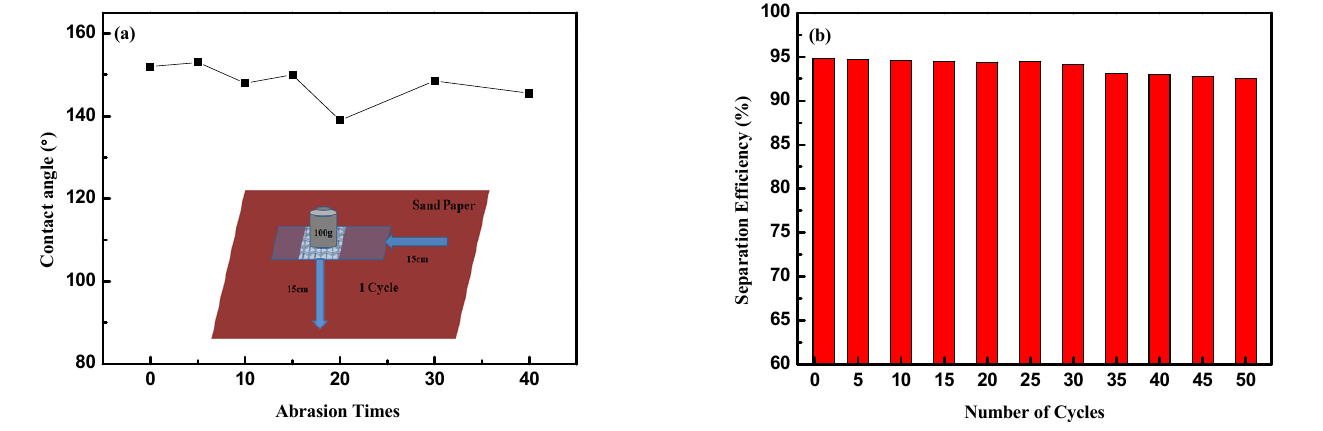
Figure 7. Durability of the coated mesh: wear resistance ( a ) and recycling separation ( b ).